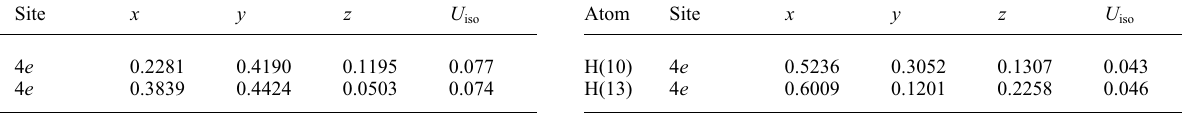
Table 3. Atomic coordinates and displacement parameters (in Å 2 )